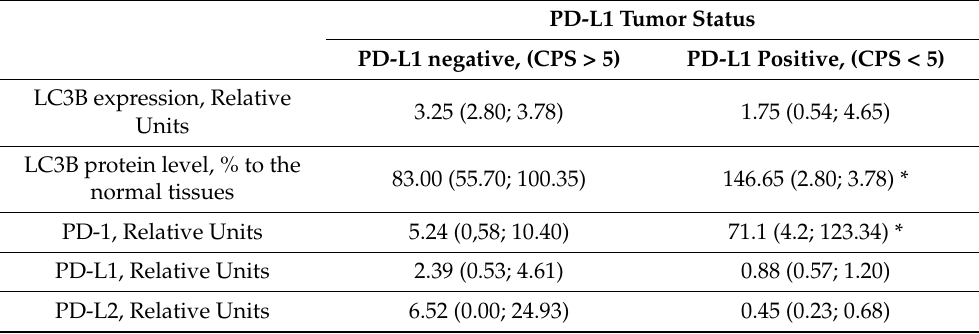
Table 7. Molecular markers in gastric cancers depending on the PD-L1 status after